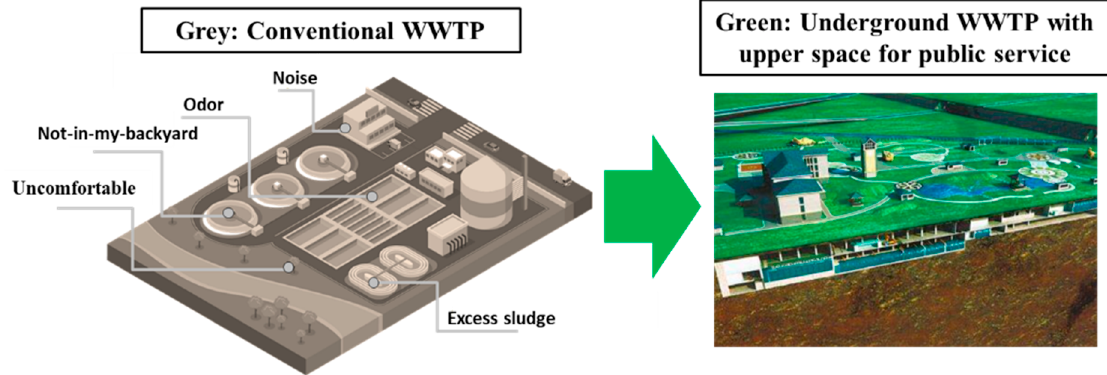
Figure 2. Concept of transformation from grey to green by underground construction.